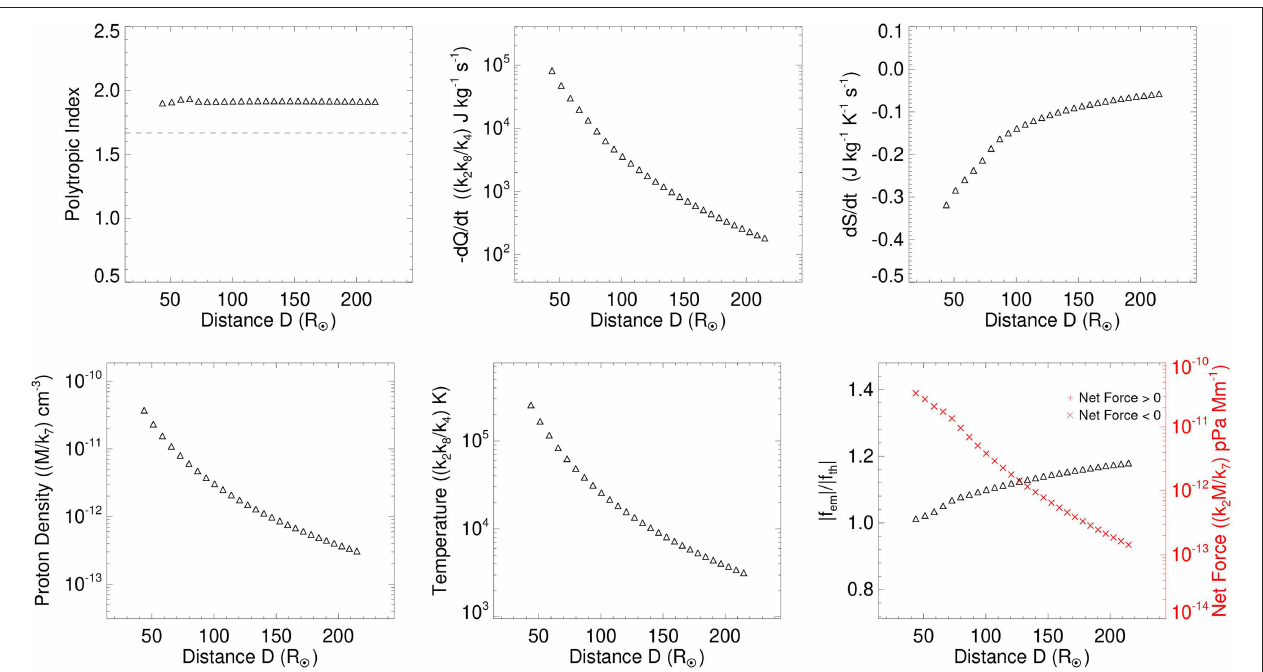
FIGURE 8 | Top : The variation of the polytropic index ( Ŵ ), cooling rate (- dQ / dt ), and rate of change of entropy ( ds / dt ) of the CME with the heliocentric distance of the CME’s center ( D ) is shown in the left, central, and right panels, respectively. Bottom : The average proton number density ( n p ) and Temperature ( T ) of the CME, and different forces acting on the CME with the heliocentric distance of its center ( D ) is shown in the left, central, and right panel, respectively. The bottom-right panel shows the ratio of absolute values of Lorentz and thermal force ( | f em | / | f th | ) (on left Y-axis) and the net force (on right Y-axis) acting inside the